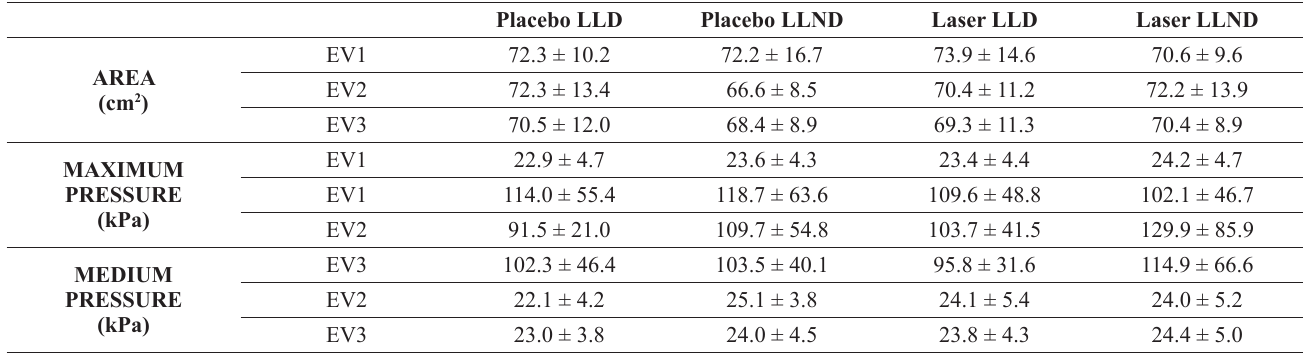
Table 2 – Baropodometry – Dinamic Analysis. Assessments occurred in the lower limb dominant (LLD) and non-dominant (LLND).